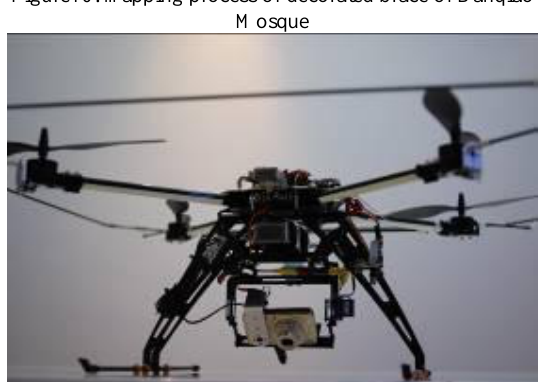
Figure11: micro Quadcopter for taking close range